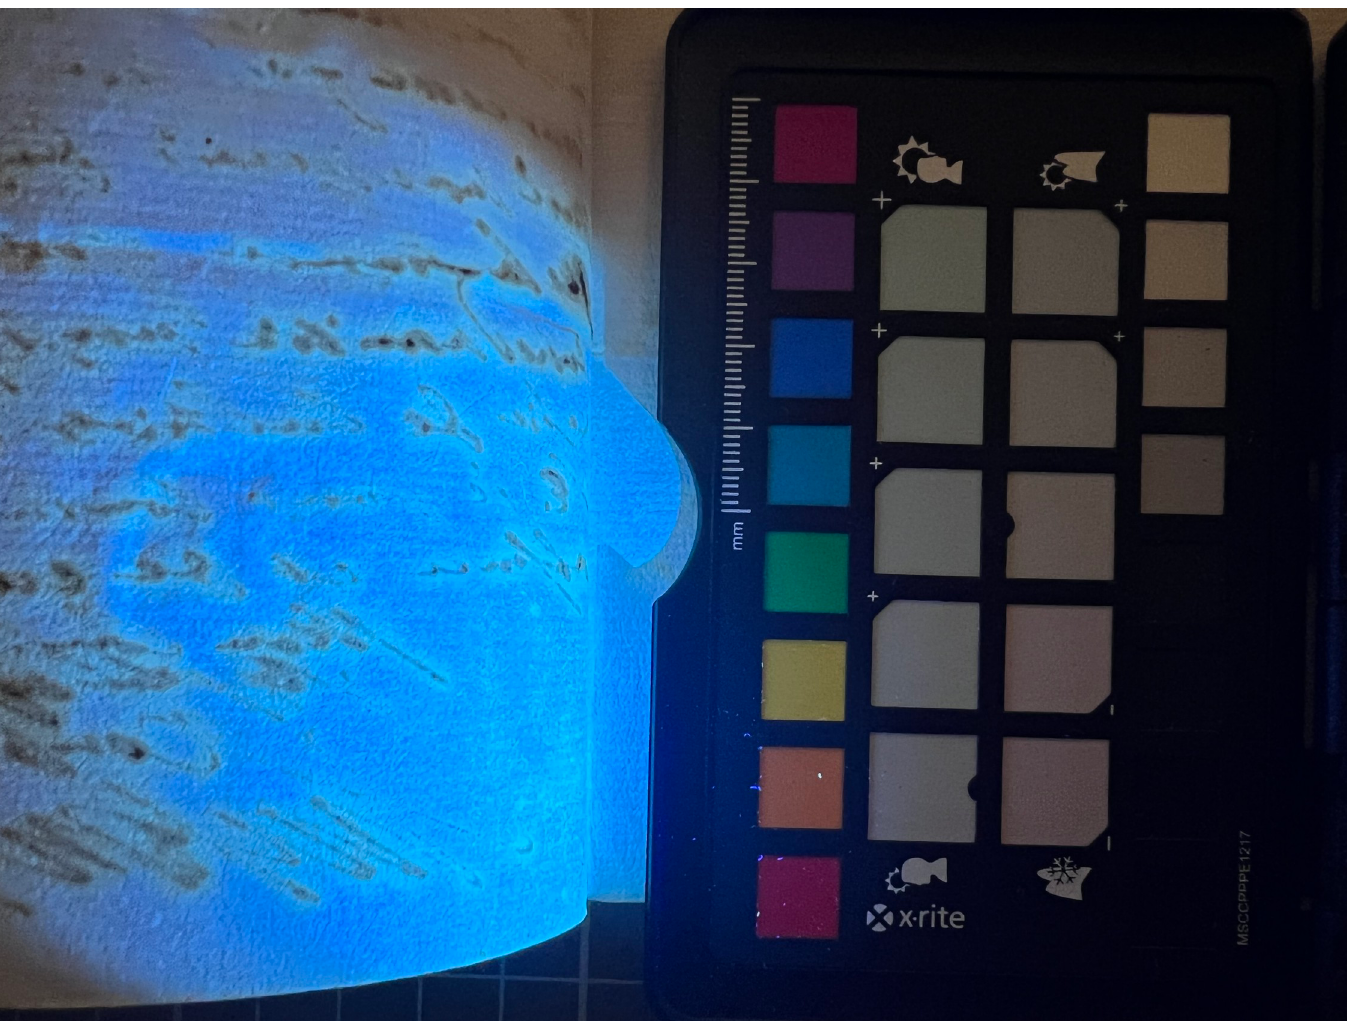
Fig 6. Fluorescence. Yellow fluorescence on the verso of corroding ink when viewed under UV light. This particular document from volume K 400 of the Azzolino collection.